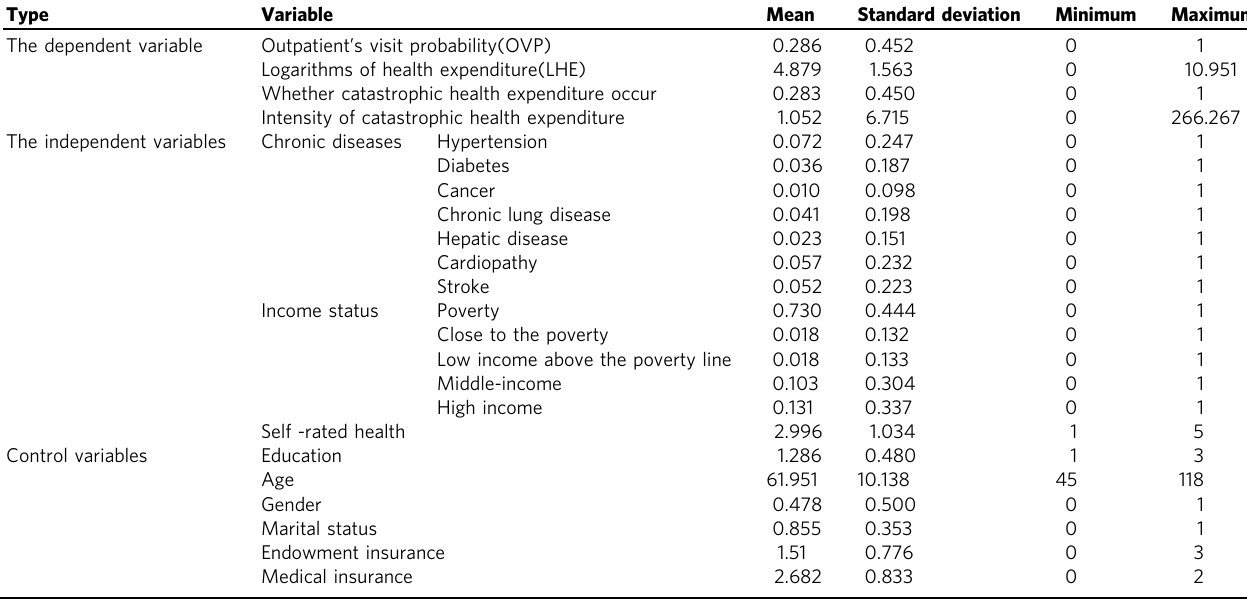
Table 2 Variables and descriptive statistics.